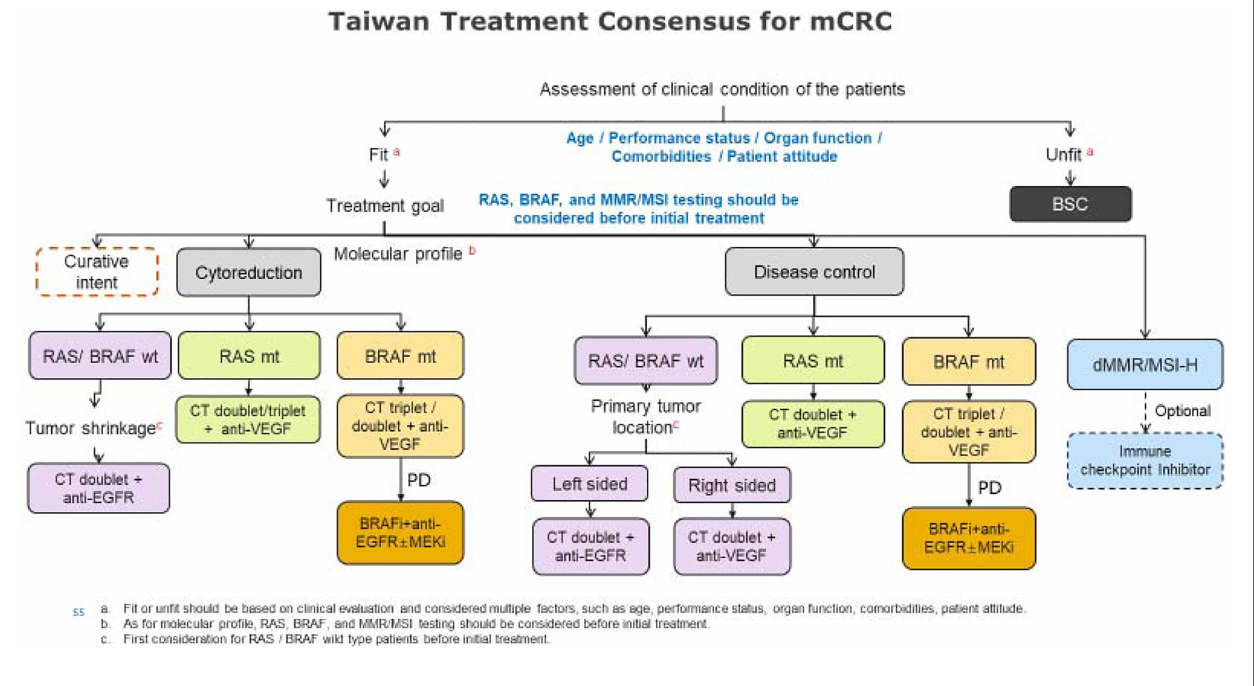
FIGURE 2 | Taiwan treatment consensus of